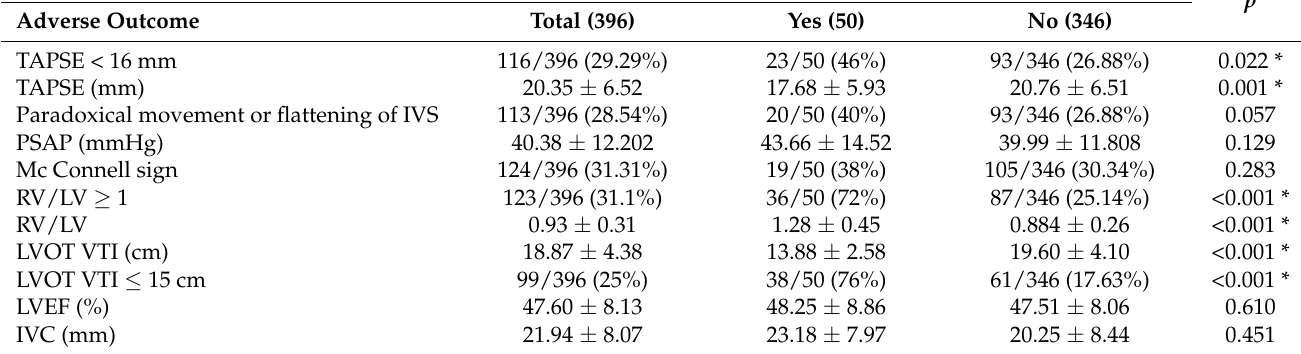
Table 2. Comparative baseline echocardiographic parameters in patients with and without in-hospital adverse outcomes.